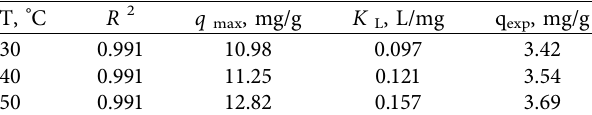
Table 5: Langmuir isotherms for Pb ions